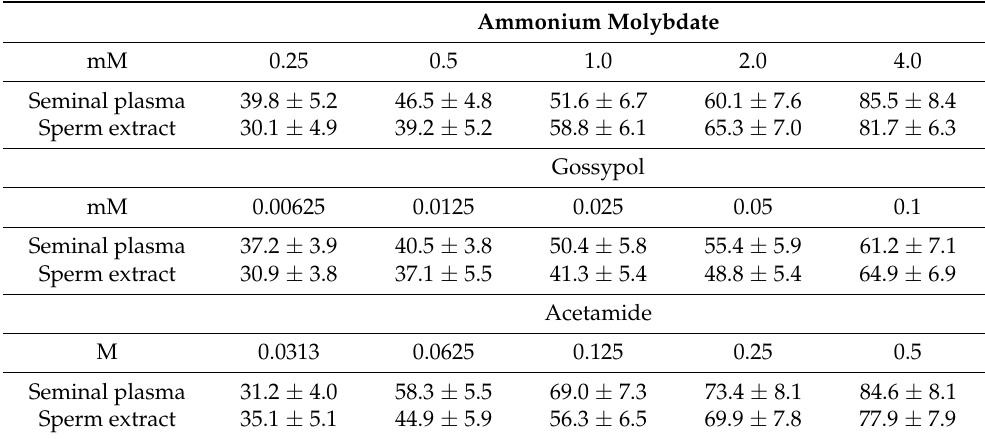
Table 2. The effect of inhibitors concentration on AcP, LDH and β -NAGase activities as the percentage of the enzyme’s inhibition (%). Values are shown as a mean ± SD, n = 3.